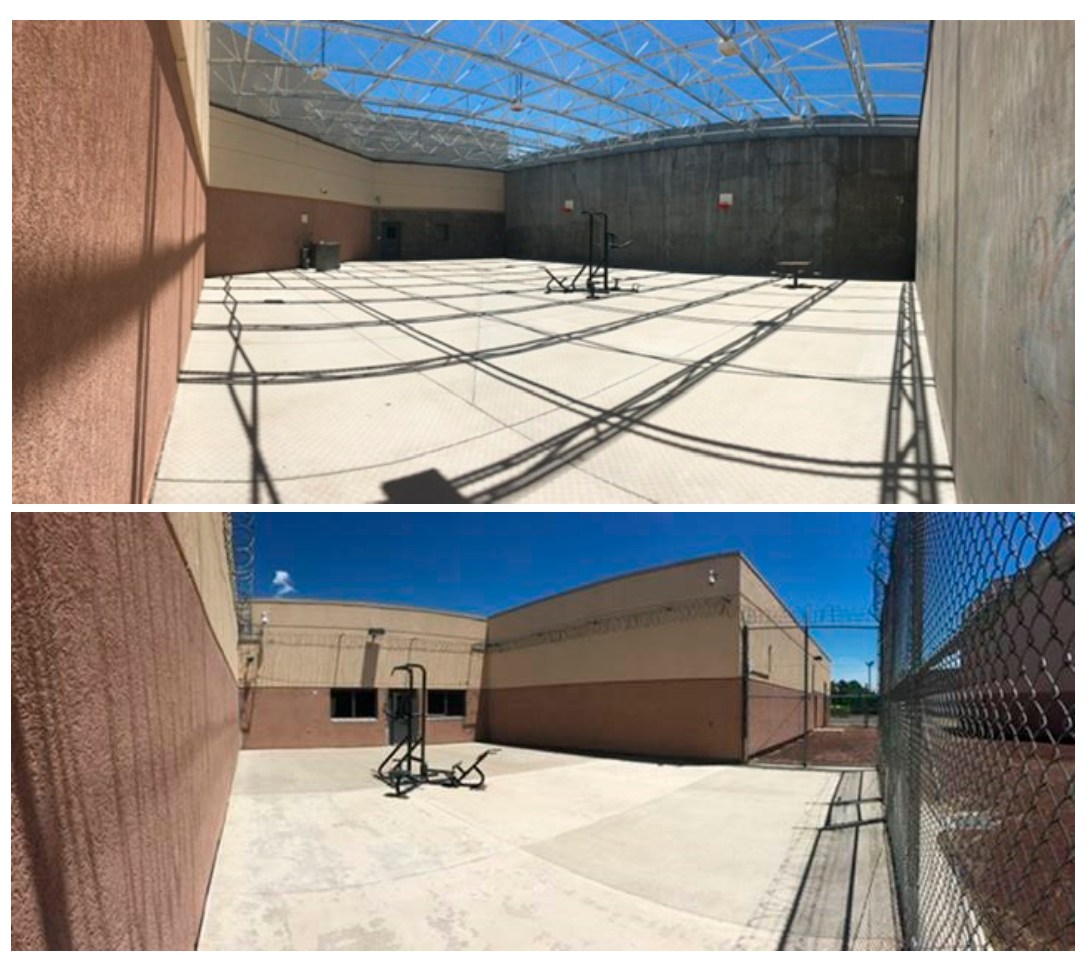
Figure 1. Recreation areas at Coconino County Detention Facility.